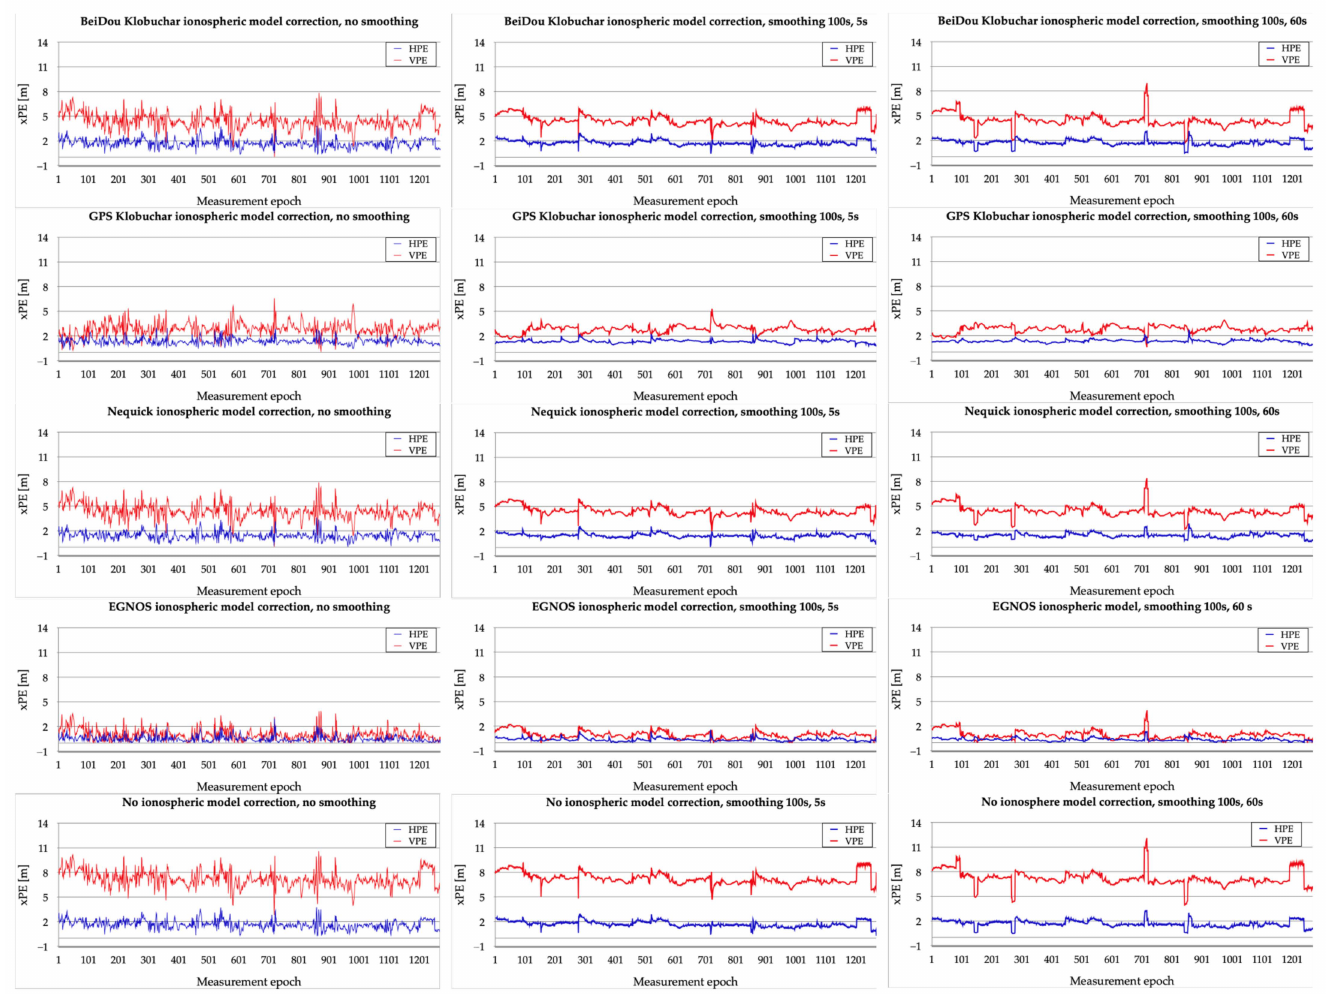
Figure 5. HPE and VPE for different variants related to ionospheric delay and phase smoothing of code